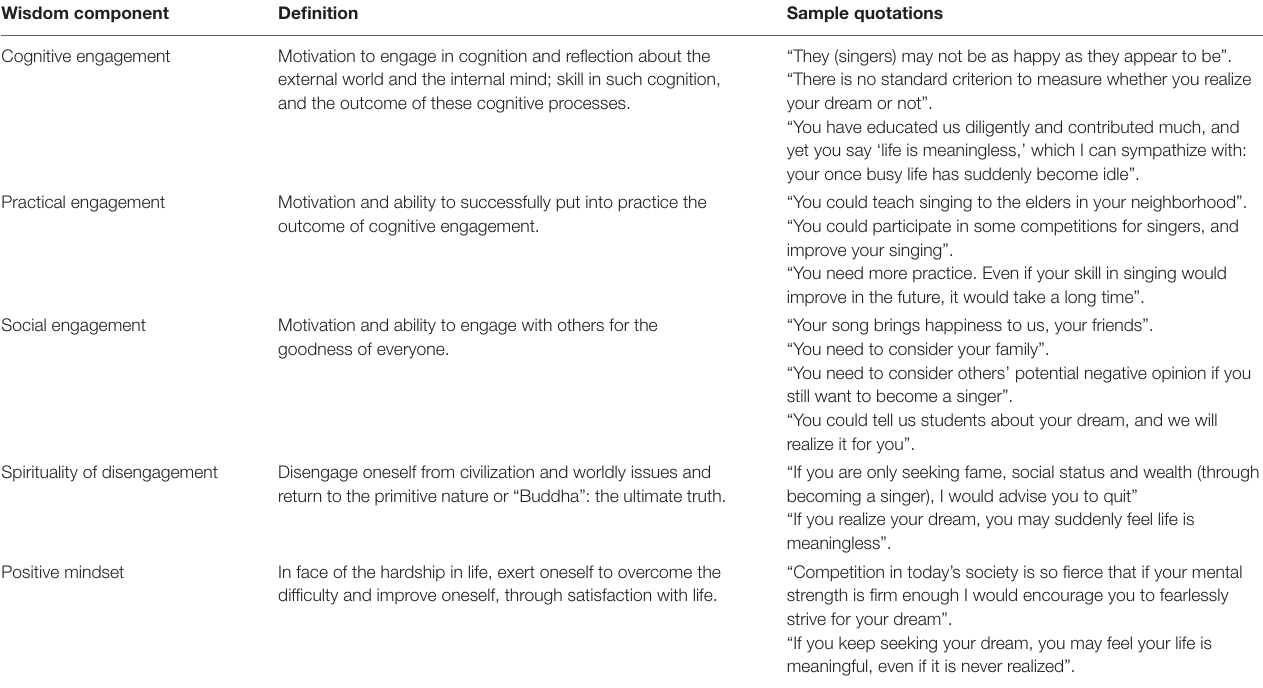
TABLE 1 | Chinese wisdom criteria and their definitions. Wisdom component